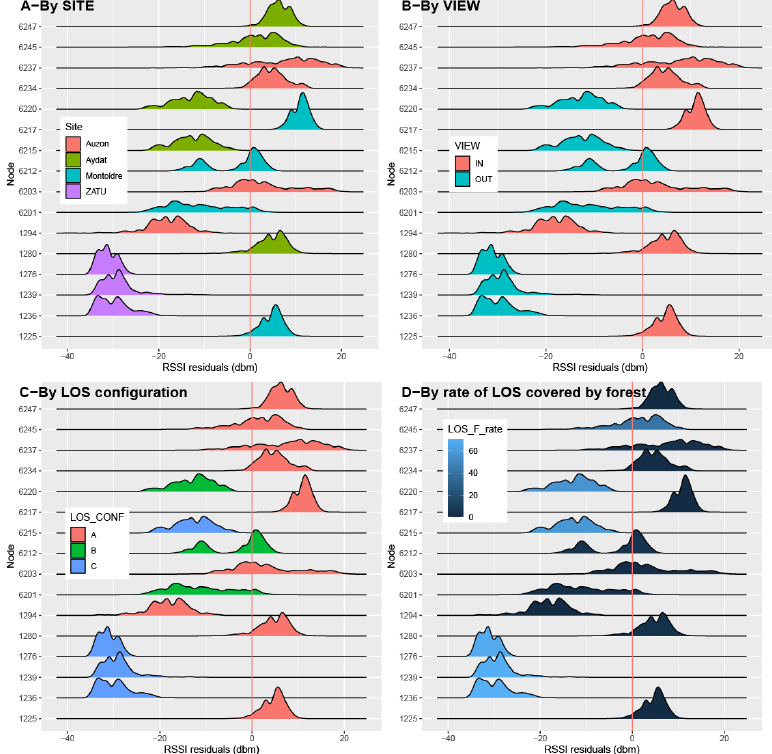
Figure 17. Regression residual analysis.